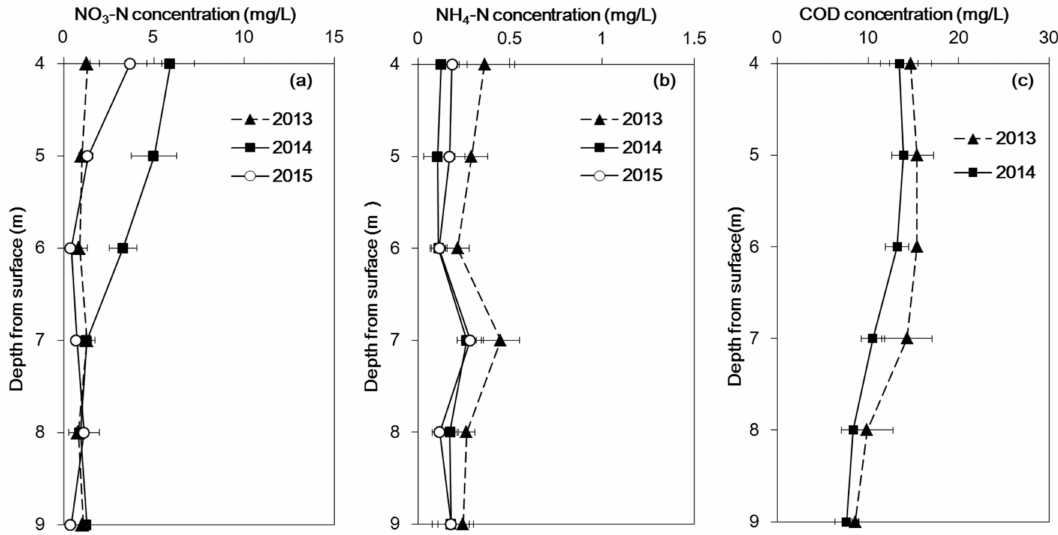
Figure 8. Vertical distributions of annual mean NO 3 -N ( a ), NH 4 -N ( b ) and chemical oxygen demand (COD) ( c ), in the groundwater in 2013, 2014 and